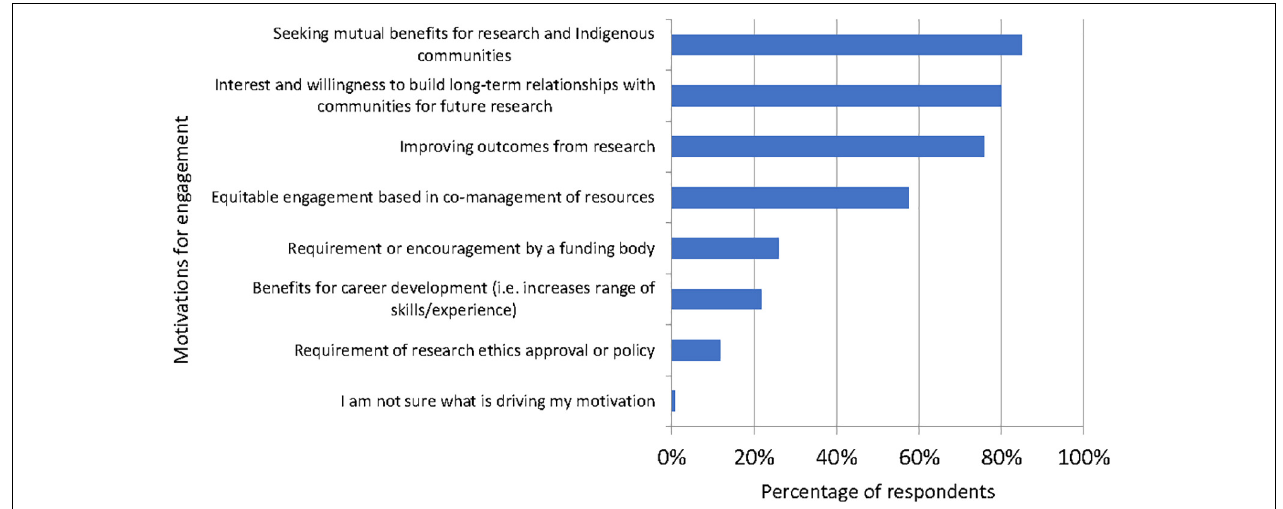
FIGURE 4 | Researchers’ motivations for engaging Indigenous communities in marine science measured as a percentage of survey respondents ( n = 120).